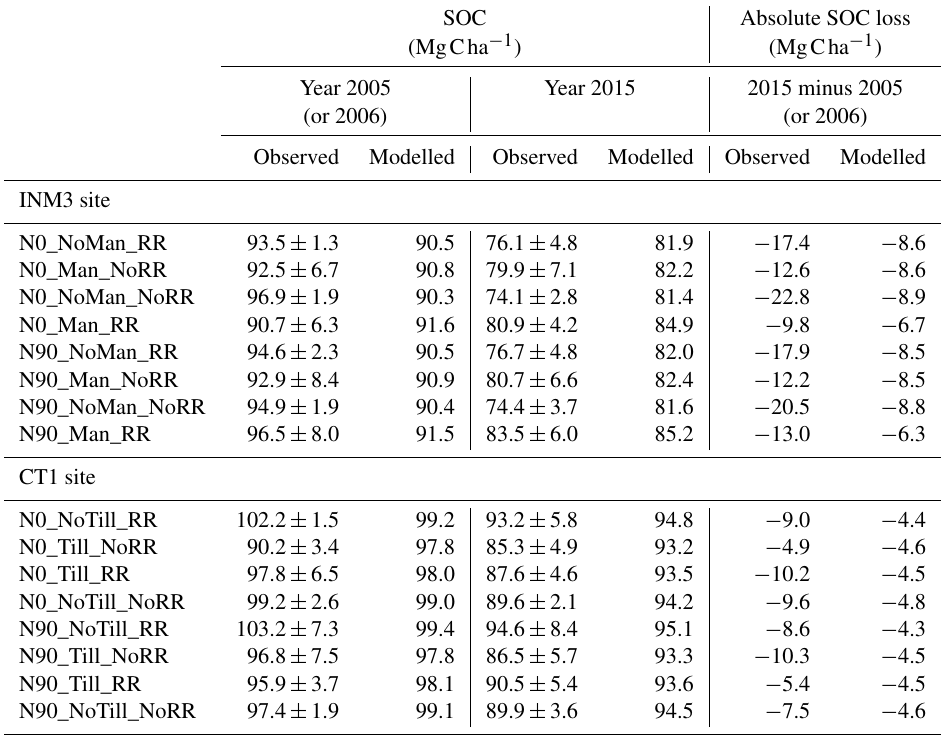
Table 4. Comparison of modelled and observed SOC stocks and absolute SOC loss for all the evaluated treatments over 2005–2015 at the INM3 and CT1 sites. The absolute SOC loss of each treatment was calculated as the difference between the first (years 2005 and 2006 for the INM3 and CT1 trials, respectively) and last sampling years (i.e., 2015). The observed SOC is represented as mean ± 1 standard deviation, deriving from the four replicates in each